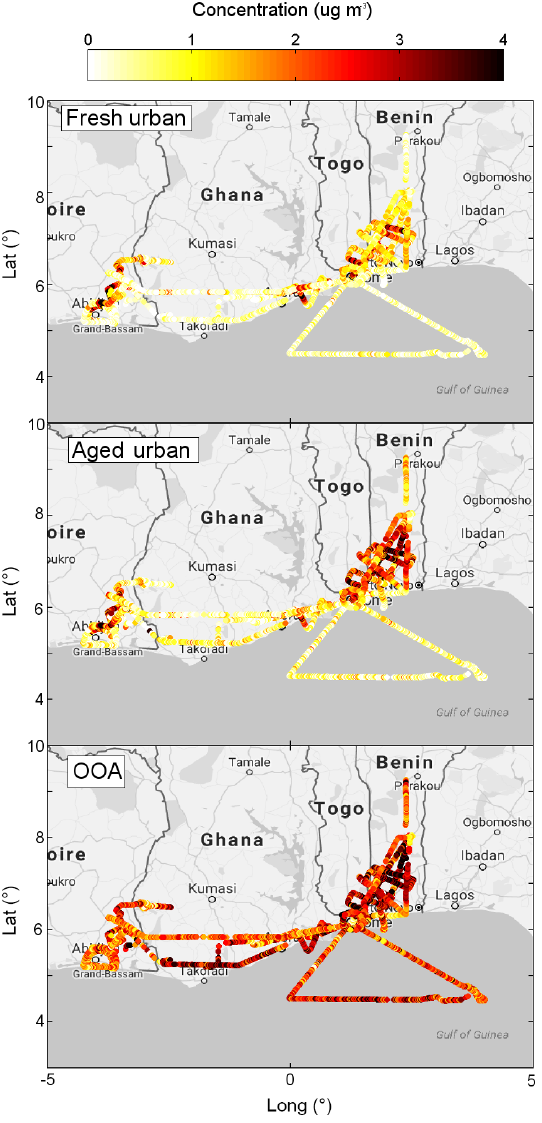
Figure 4. Spatial distribution of OA concentration associated with three PMF factors: fresh urban, aged urban and oxygenated organic aerosol.